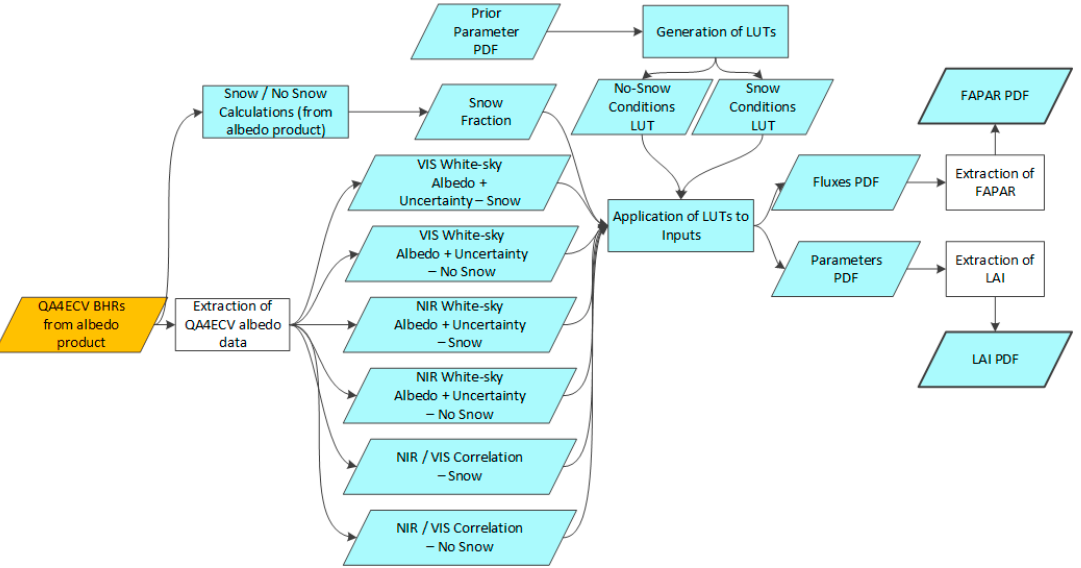
Figure 7 . QA4ECV two-stream inversion package (TIP) leaf area index (LAI)/fraction of absorbed photosynthetically active radiation (FAPAR) product top-level traceability chain. BHR: bi-hemispherical diffuse reflectance; PDF: probability density function; VIS: visible; NIR: near-infrared; and LUT: look up table.